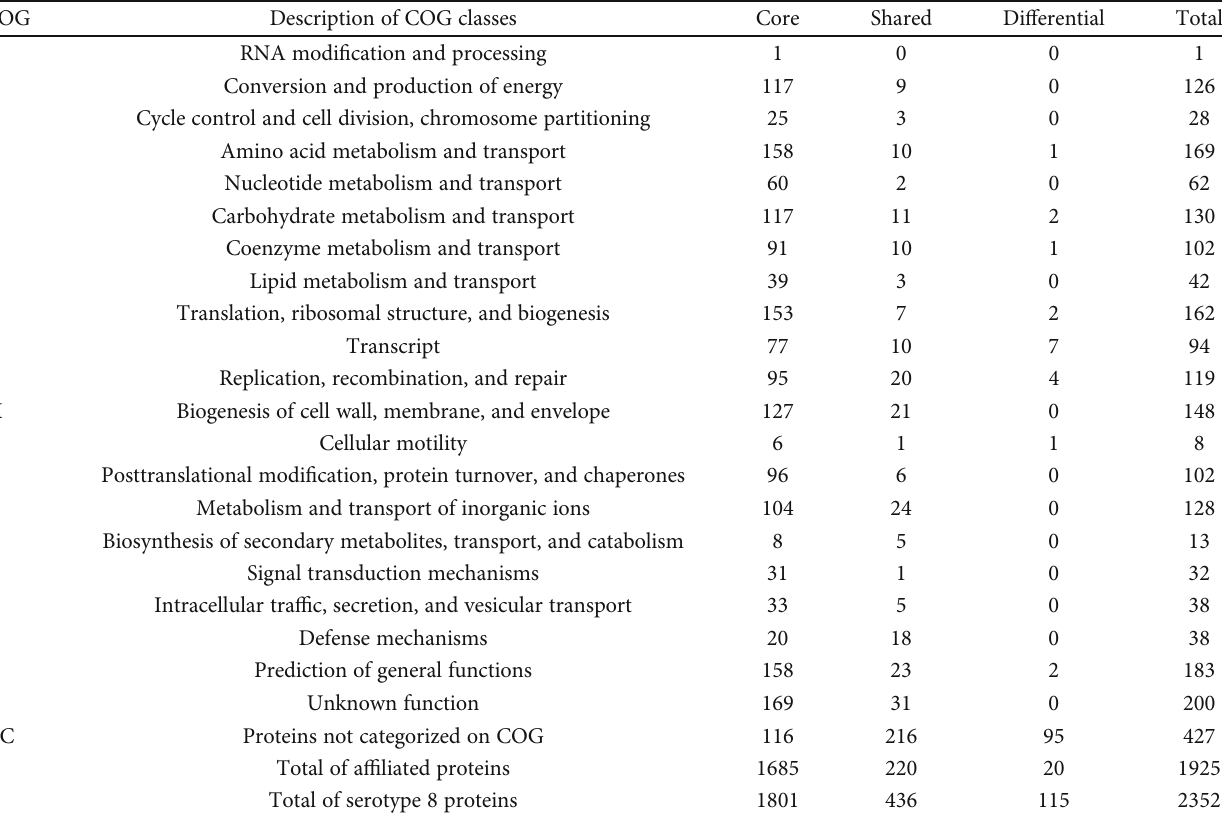
Table 2: Coding sequences of A. pleuropneumoniae serotype 8.